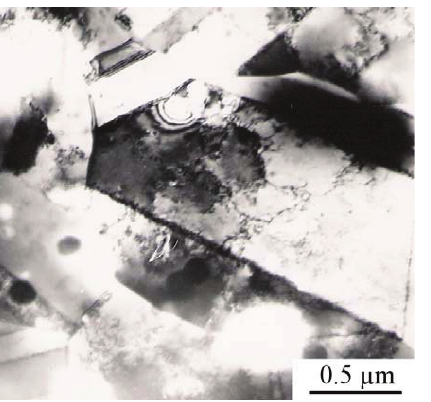
Figure 3. Examples of variation of the coefficient of fric- tion along the sliding distance.